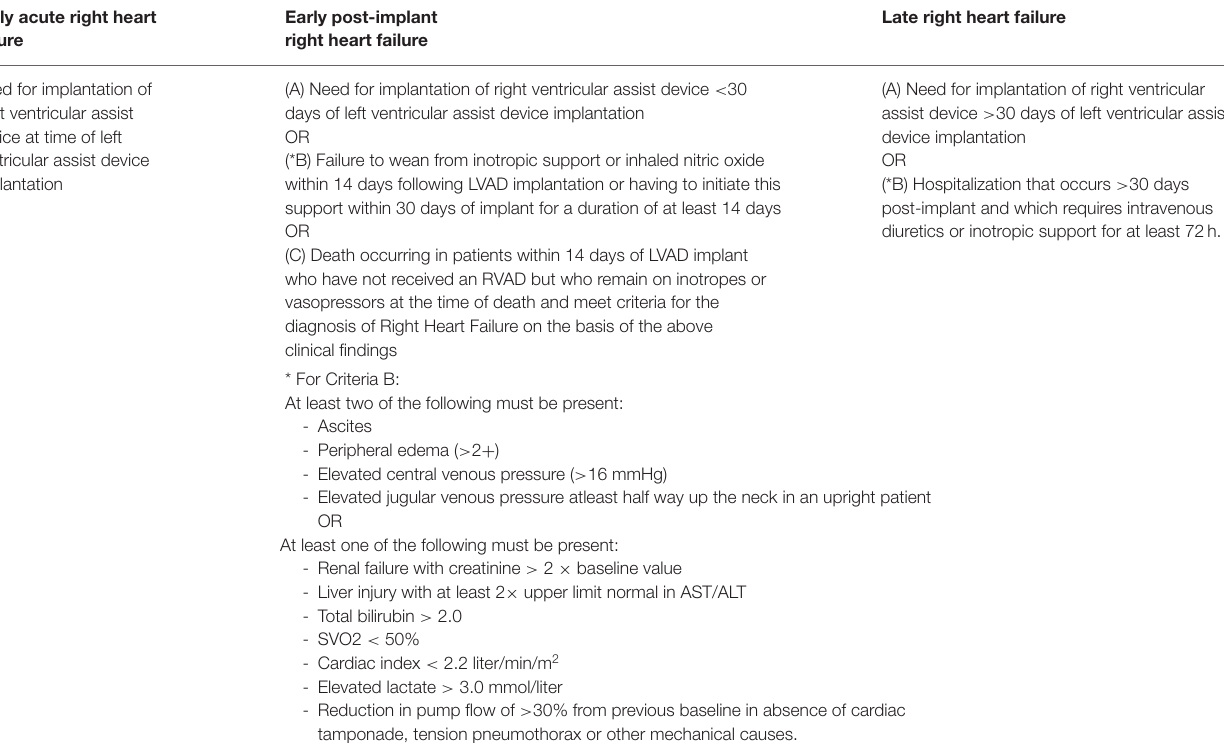
TABLE 3 | 2020 Academic Research Consortium definition for right heart failure. Early acute right heart